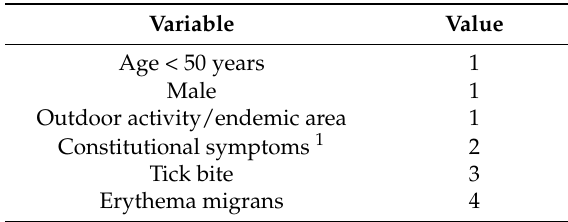
Table 1. The Suspicious Index in Lyme Carditis (SILC) score evaluates the likelihood that a patient’s high-degree heart block is caused by Lyme carditis. The total summed score indicates low (0–2), intermediate (3–6), or high (7–12) suspicion of Lyme